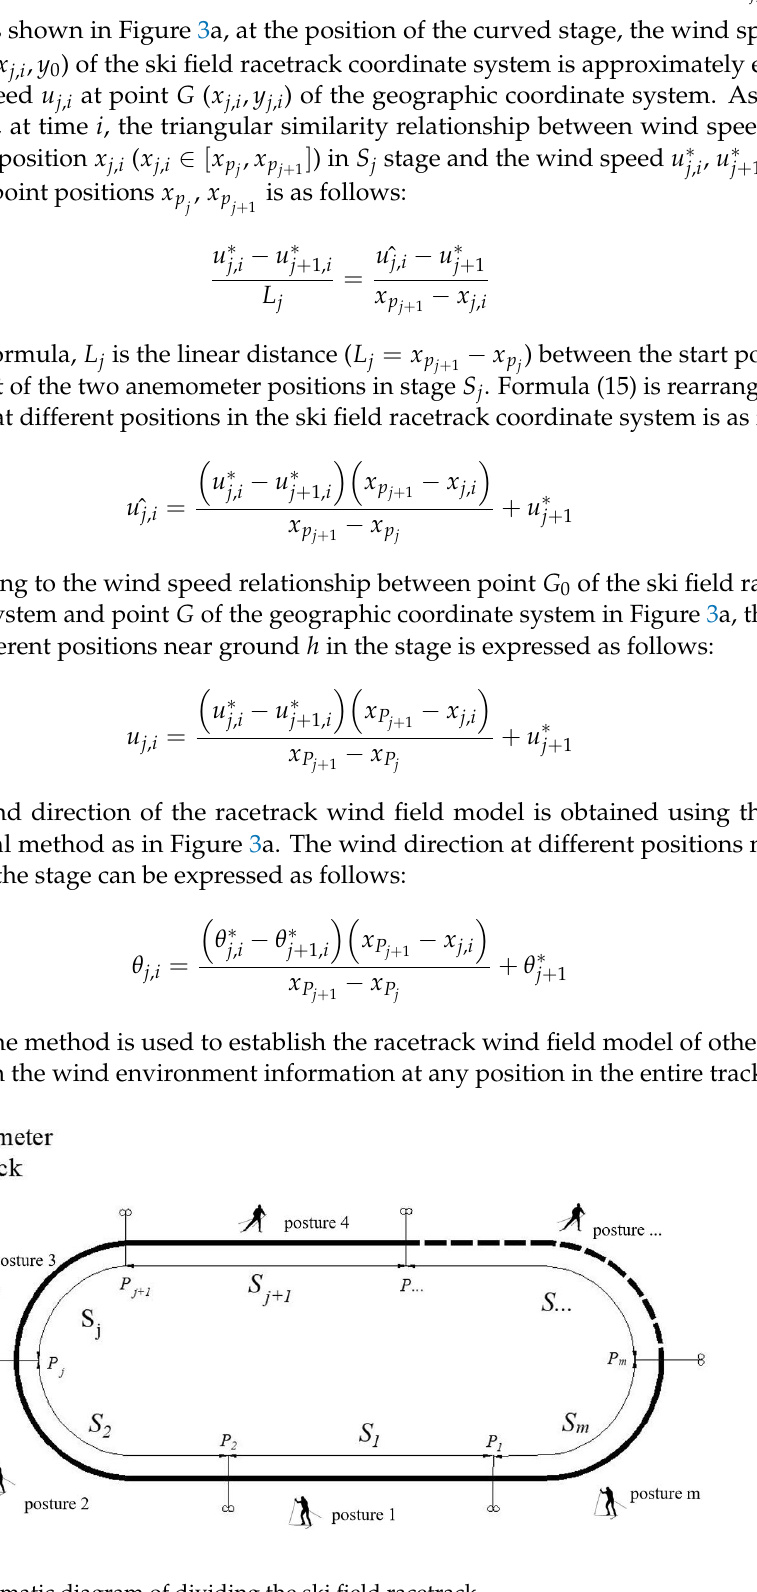
Figure 2. Schematic diagram of dividing the ski field racetrack.